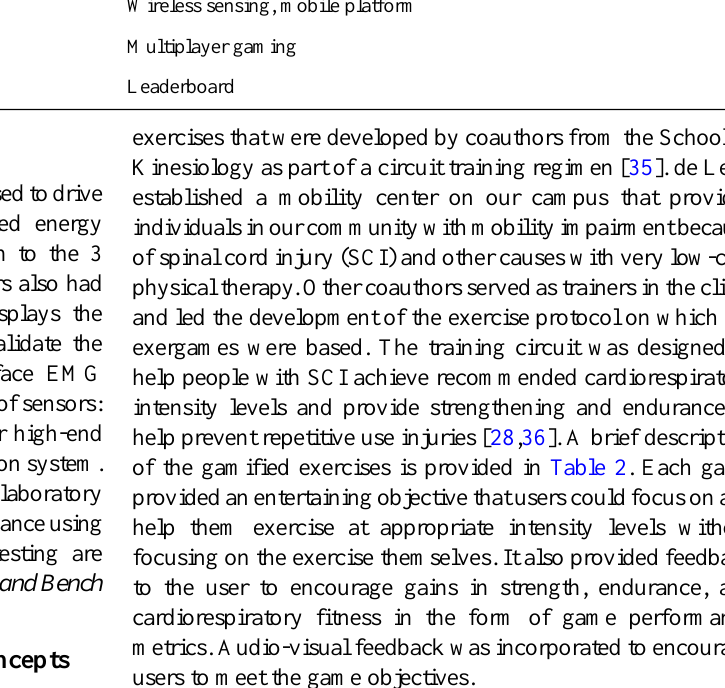
Spinning, boxing, and arm resistance gamesHolistic exercise workout in wheelchairs Electromyography-driven game engines (game performance correlates with effort Calories metric, trends pageFitness